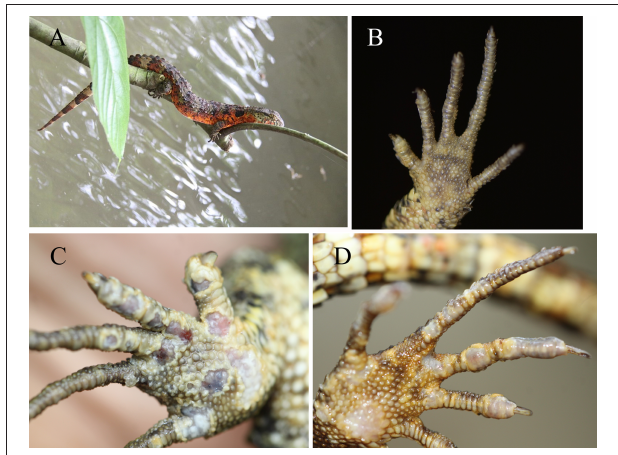
FIGURE 1 | Foot comparison of healthy and sick crocodile lizards. Healthy crocodile lizard (A) . Healthy foot (B) . Sick foot (C,D) . Sick crocodile lizards were afflicted with skin